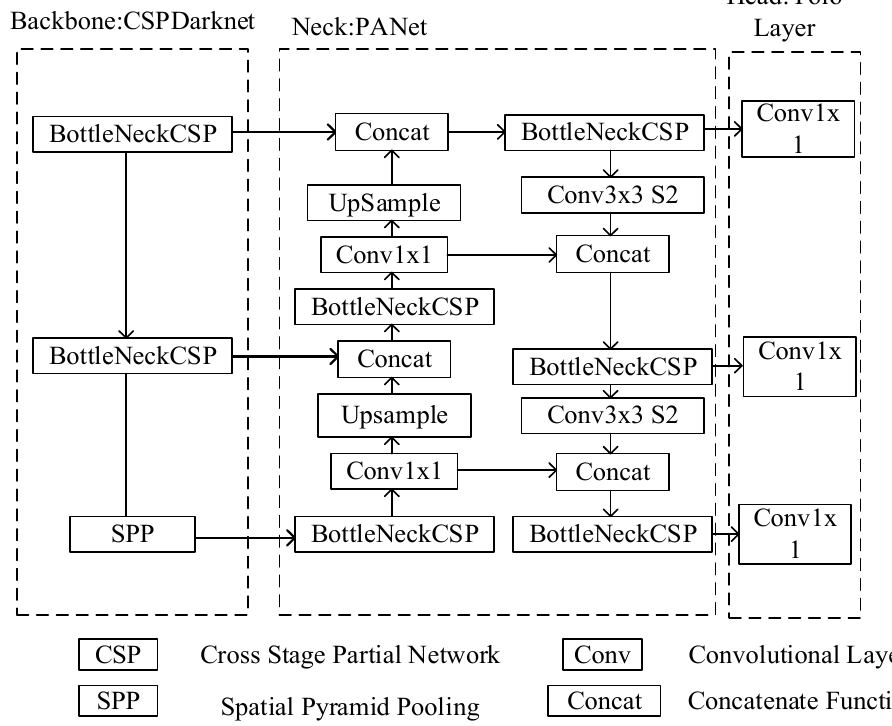
Figure 5. YOLOv5 network model diagram.